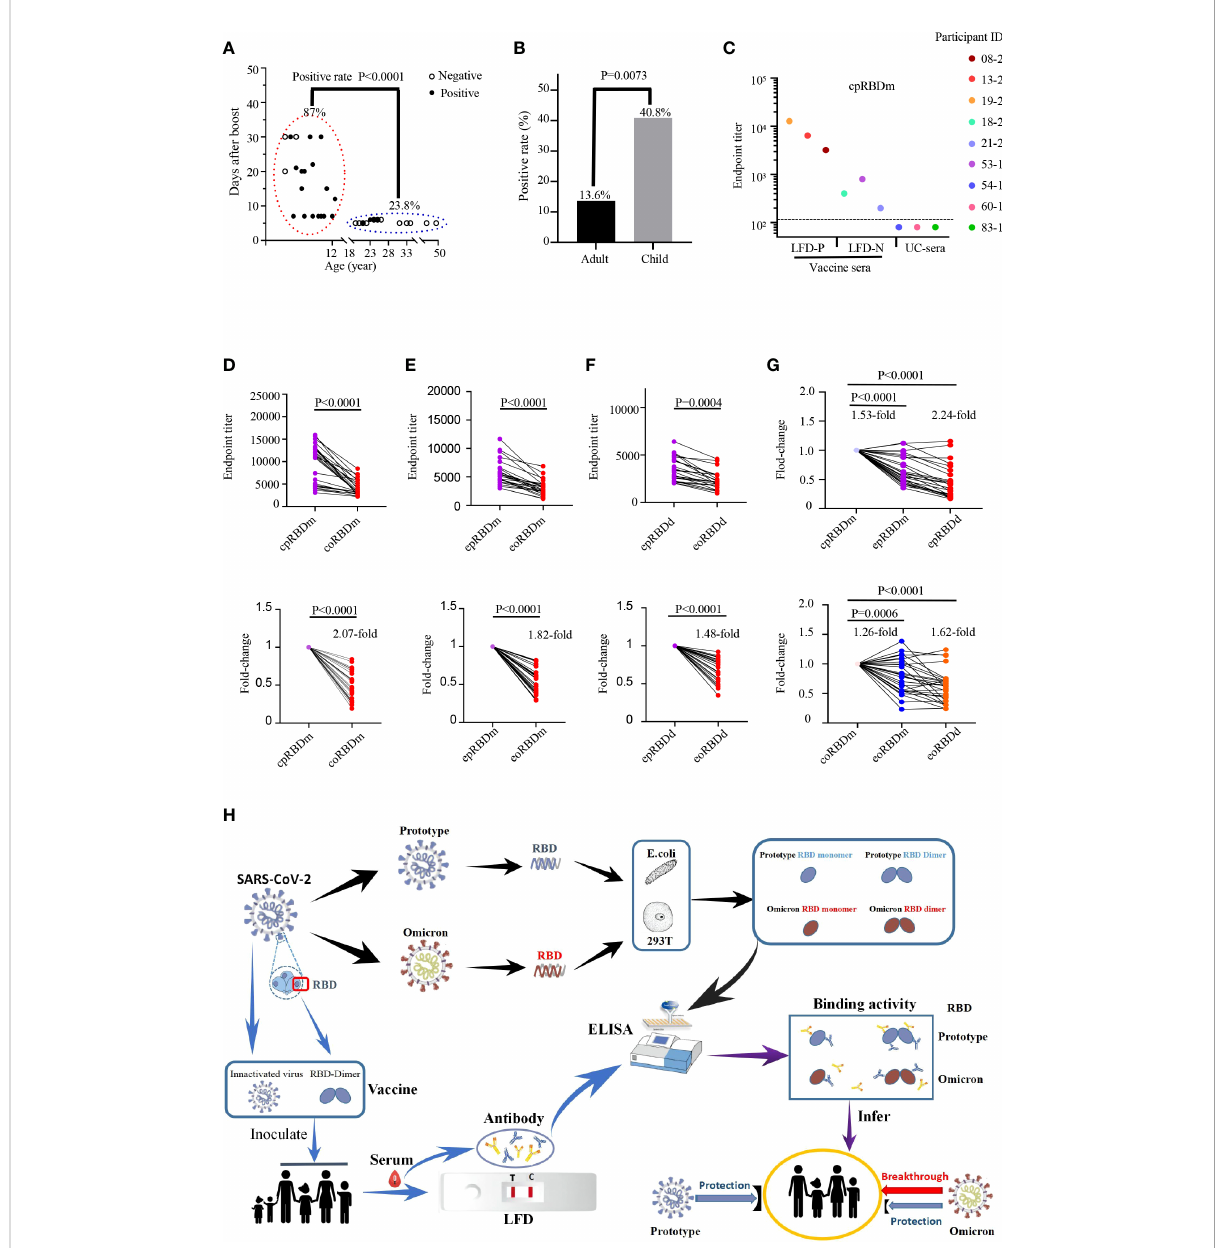
FIGURE 2 Reactivity of human sera with SARS-CoV-2 spike protein and recombinant RBDs. (A, B) Detection of anti-SARS-CoV-2 spike protein antibodies in human sera with LFD assays. (A) Examination of the contributions of age and sample collection time point to LFD-positive rates with the chi-square test. Children LFD-positive rate: (20 of 23, 86.9%); adult LFD-positive rate: (5 of 21, 23.8%). Child sera were collected at 7 days to 1 month after boost. Adult vaccine sera were collected within 1 week after boost. (B) Comparison of the LFD-positive rate of vaccine sera between adults (6 of 44, 13.6%) and children (20 of 49, 40.8%) with chi-square test. (C) Titration of SARS-CoV-2 RBD-speci fi c antibodies in LFD-positive vaccine sera (participant IDs: 08-2, 13-2 and 19-2; LFD-P), LFD-negative vaccine sera (participant IDs: 18-2, 21-2 and 53-1; LFD-N), and unimmunized sera (participant IDs: 54-1, 60-1 and 83-1; UC-sera) by ELISA using the recombinant RBD monomer as coating proteins. The dashed line indicates the cutoff value. (D-F) Reactivity of 26 LFD-positive vaccine sera (further details in Supplemental Figure 1A and Supplemental Table 1) to commercial prototype and omicron RBD monomer (D) , E. coli -expressed prototype and omicron RBD monomer (E) , and E. coli -expressed prototype and omicron RBD dimer (F) . Top panels: absolute titers; bottom panels: fold change. cpRBDm/coRBDm: commercial prototype/omicron RBD monomer; epRBDm/eoRBDm: E. coli -expressed prototype/ omicron RBD monomer; epRBDd/eoRBDd: E. coli -expressed prototype/omicron RBD dimer. (G) Fold change for comparison between commercial and lab-made RBDs. Prototype SARS-CoV-2 RBDs (top panel) and Omicron RBDs (bottom panel). Fold change is de fi ned as mean fold change. Each dot represents a biological replicate, and the assays were performed three times (A, C-G). (H) Schematic diagram showing reduced binding activity of vaccine serum to Omicron